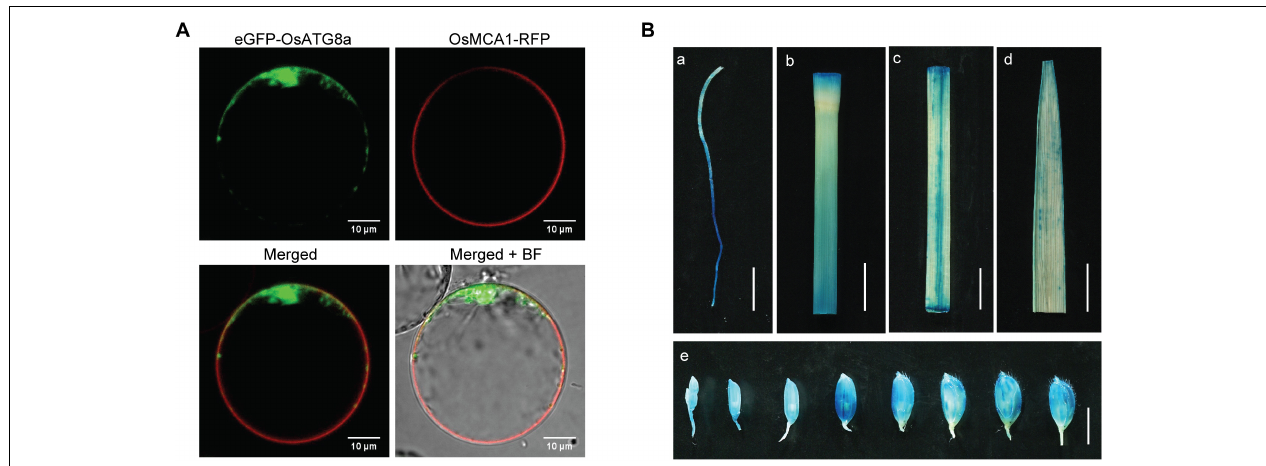
FIGURE 1 | Protein subcellular localization of OsATG8a and expression patterns of OsATG8a gene. (A) Subcellular localization of OsATG8a in rice protoplasts. Panels showed the image of eGFP-OsATG8a, the cell membrane marker OsMCA1-RFP, merged of eGFP-OsATG8a and OsMCA1-RFP, and overlap image of mergerd and bright-field (BF), respectively. Scale bars, 10 µ m. (B) GUS histochemical staining of Pro OsATG 8 a -GUS transgenic rice, tissues used for GUS staining including root from 14-day-old seedlings cultured hydroponically (a) , culm (b) , leaf sheath (c) , leaf blade (d) , and developing seeds (e) . Scale bars, 1 cm in (a–d) , 5 mm in (e) .